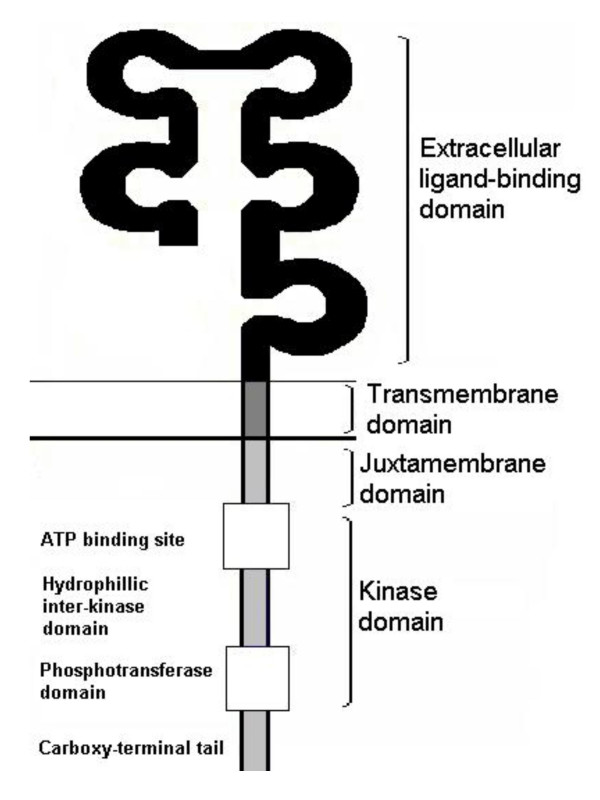
Schematic diagram of the receptor tyrosine kinase KIT.